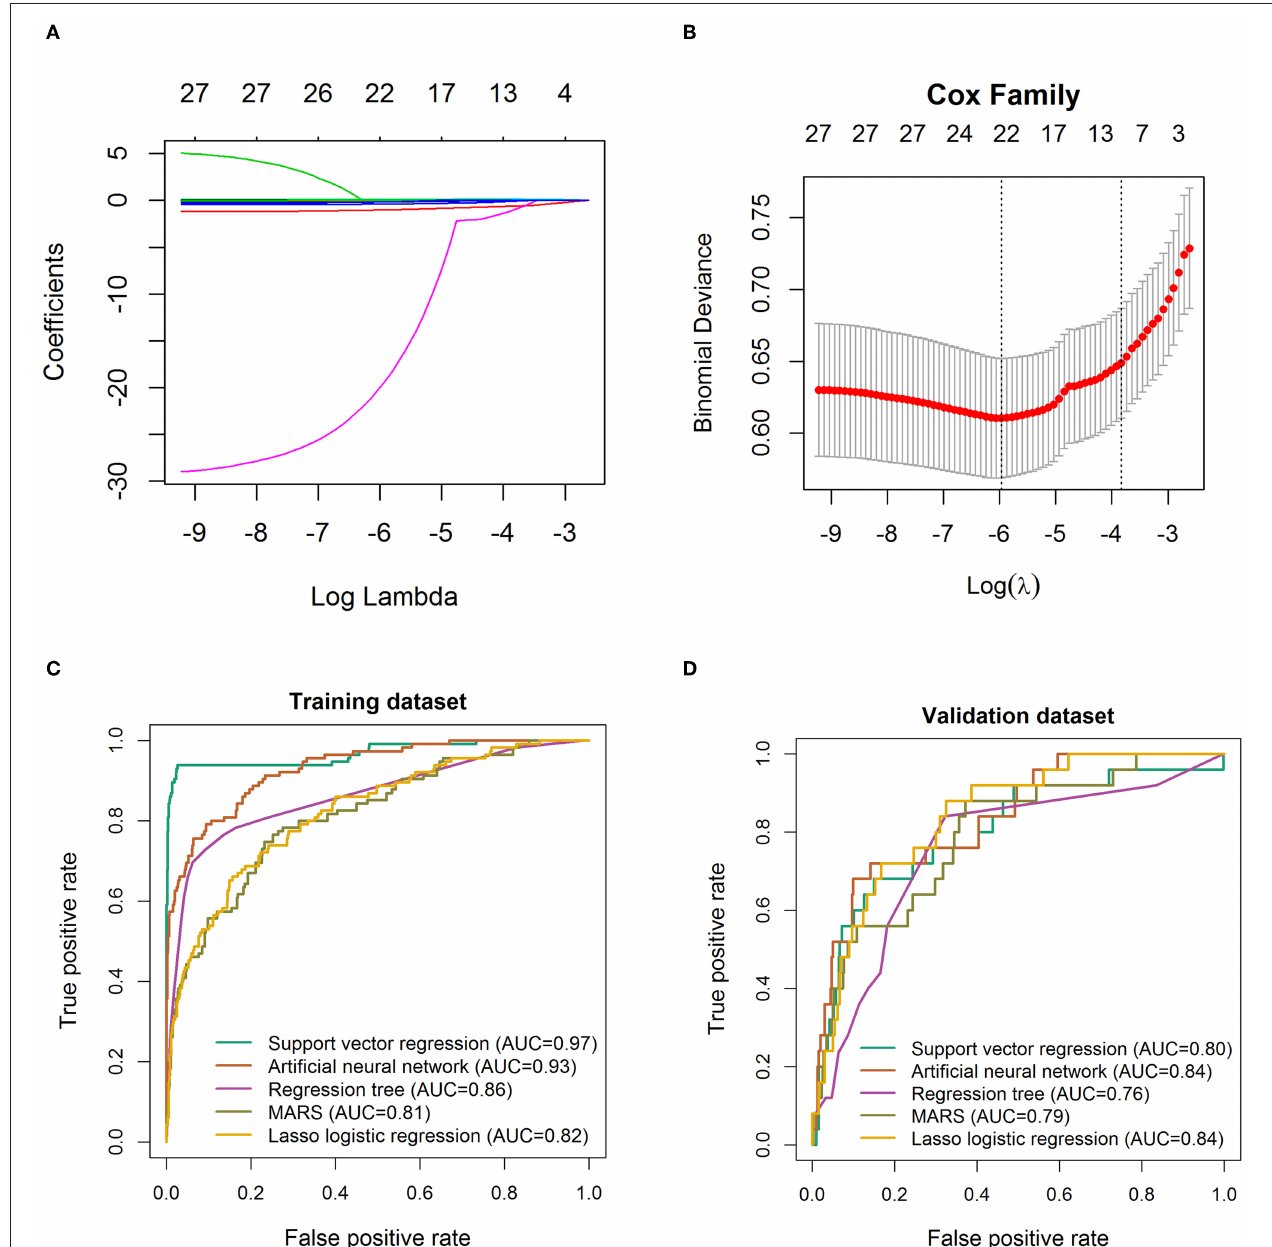
FIGURE 4 | Feature selection using the least absolute shrinkage and selection operator (LASSO) logistic regression model. (A) LASSO coefficient profiles of the 29 baseline features. (B) Tuning parameter ( λ ) selection in the LASSO model used 1,000-fold cross-validation via minimum criteria. Receiver operating characteristic curve for the performance of different machine learning techniques to distinguish individuals with COVID-19 from those with critical illness COVID-19 in the training cohort (C) and validation cohort 1 (D) , respectively. AUC, area under the receiver operating characteristic curve. The true positive rate represents module sensitivity, whereas the false positive rate is one minus the